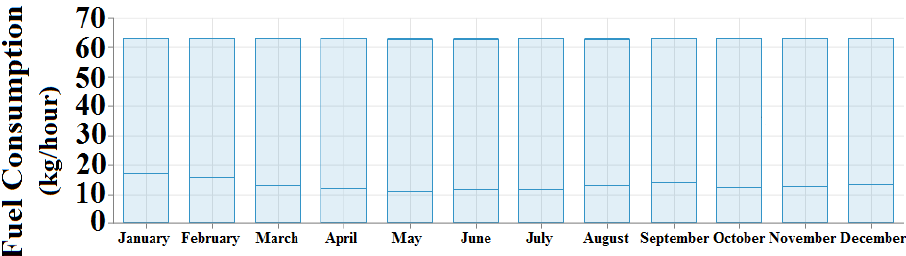
Figure 27. Average monthly utilization of biomass-based fuel resource for case IV (Ba/Bi/H/S).